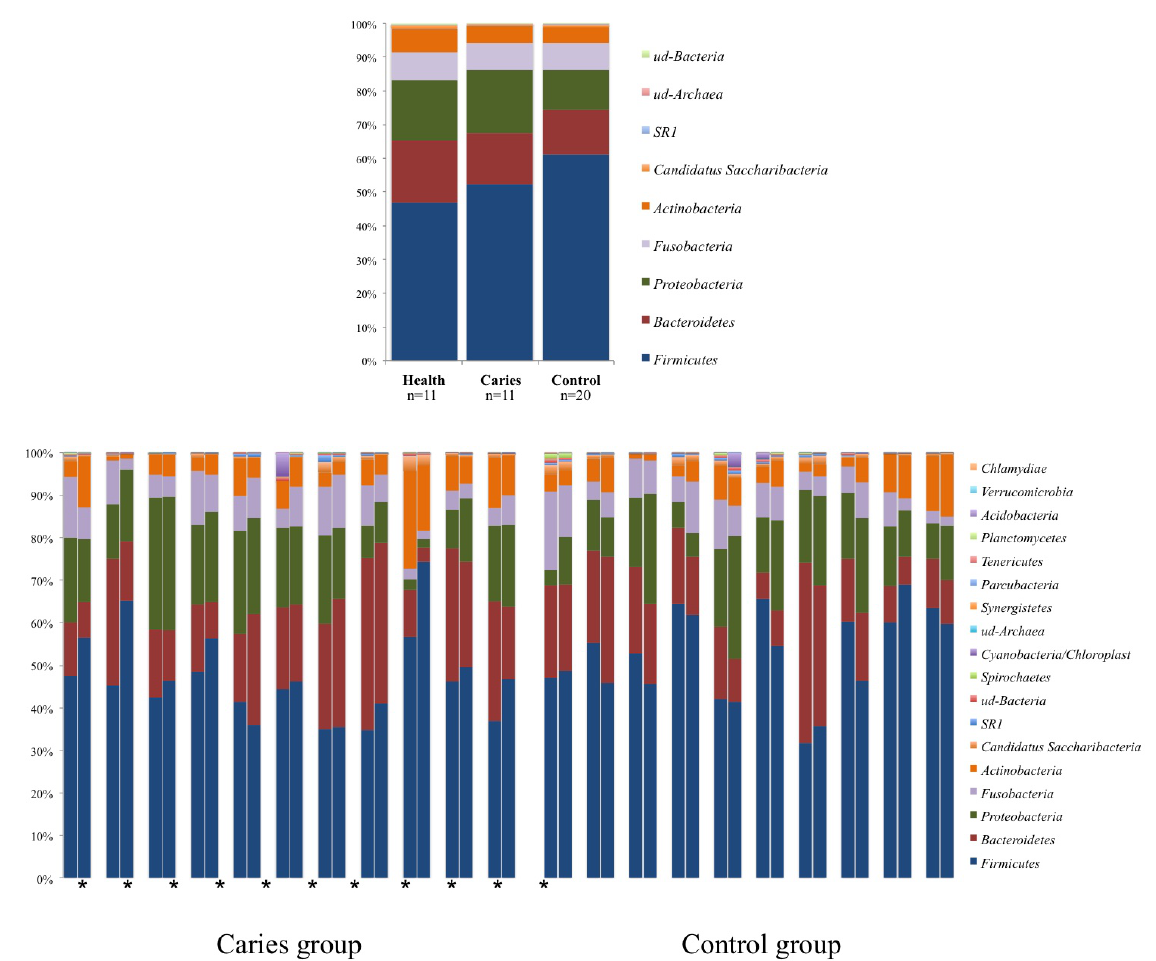
Figure 2. Phyla distribution: ( top ) the median values for each phyla and group; and ( bottom ) all individual values. * Represents Children with caries.